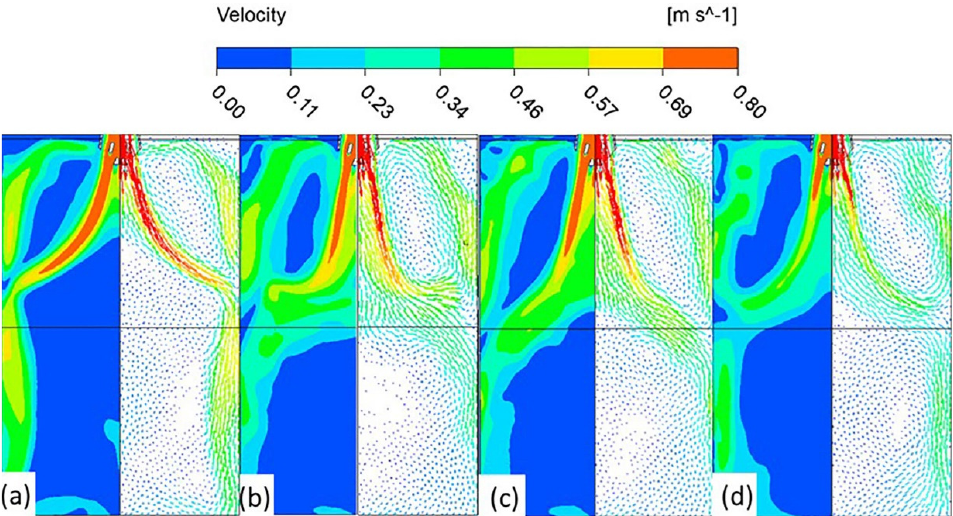
Figure 11. Distribution of velocity and velocity vector on the centrally symmetric plane at different currents. ( a ) No EMBr, ( b ) 300-200, ( c ) 800-600 and ( d ) 1100-800 A.